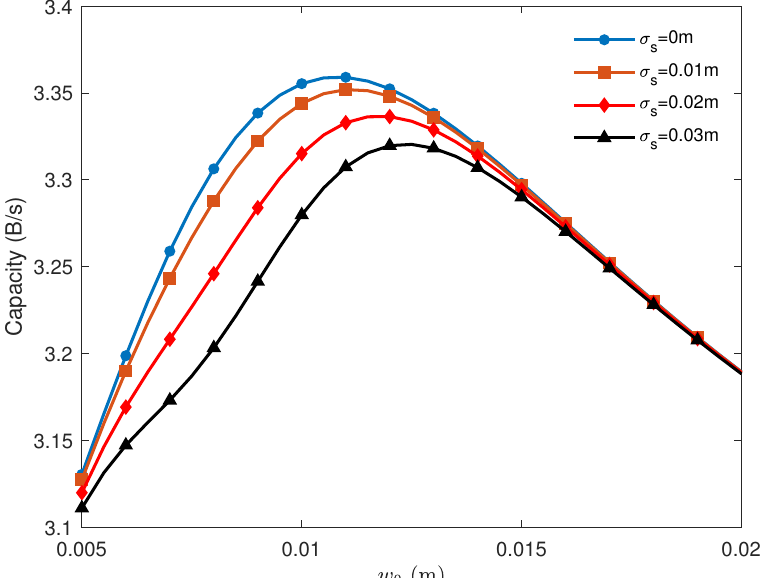
Figure 7. Information capacity of OAM channels versus the ratio of temperature and salinity (cid:118) and turbulence anisotropy